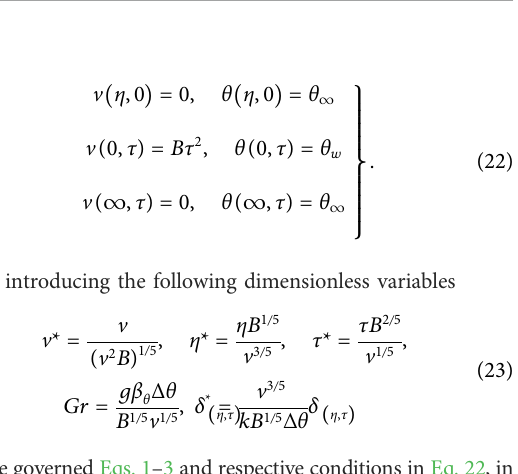
FIGURE 4 Velocity plot for α when β (cid:3) γ (cid:3) 0 . 8 , Pr (cid:3) 11 . 4 , Gr (cid:3) 8 . 0 , β 1 (cid:3) 1 . 4 , ( a ) : t (cid:3) 2 . 0 ; and ( b ) : t (cid:3)